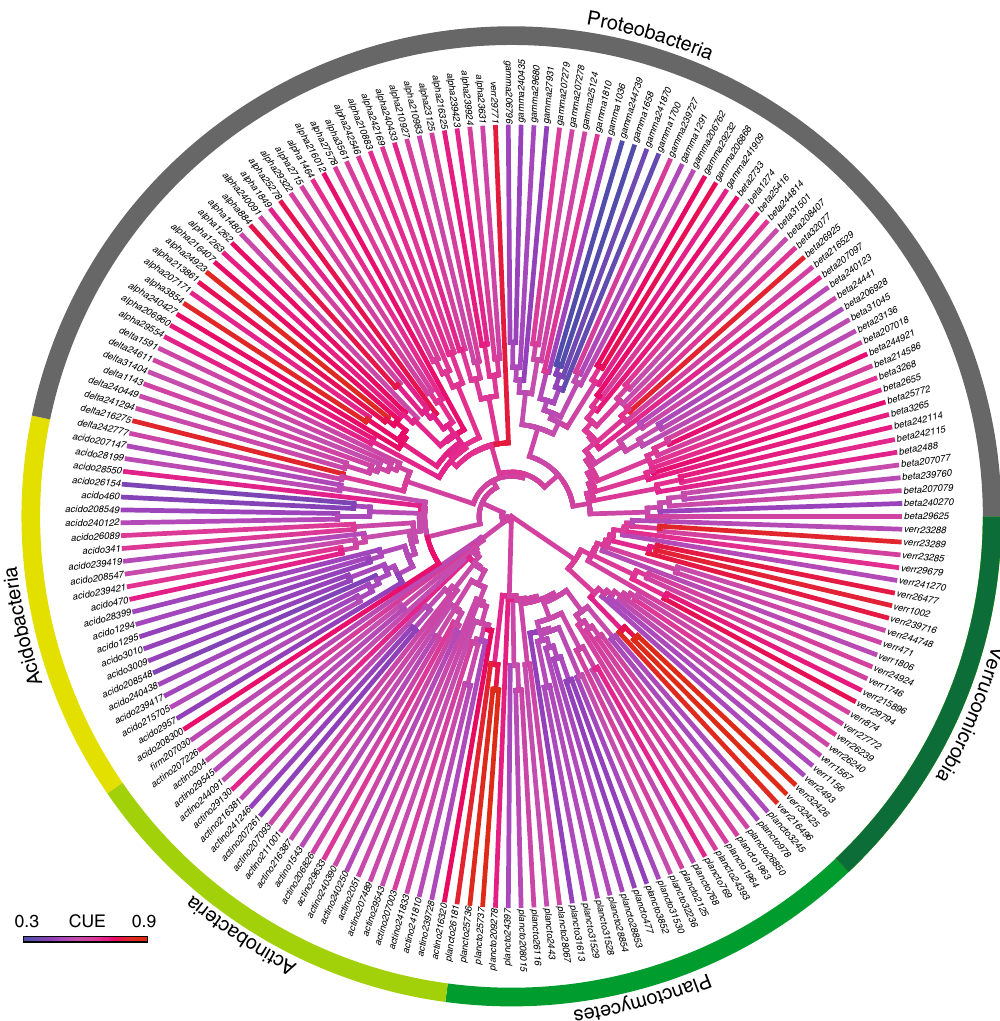
Fig. 3 Phylogenetic heatmap of potential CUE. Phylogenetic heatmap of potential CUE values from draft metabolic models. Labels on tips correspond